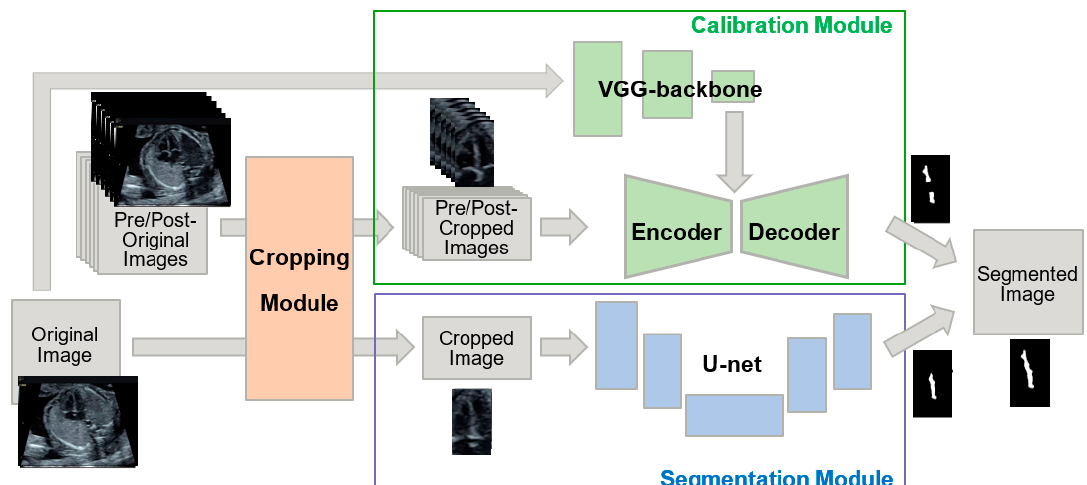
Figure 2. Overview of Cropping-Segmentation-Calibration (CSC). A “cropping module” and “calibration module” were added to improve the U-net-based segmentation results from the “segmentation module”. The cropping module crops out the area around the ventricular septum. Moreover, the calibration module, which consists of an encoder–decoder (ED) and a Visual Geometry Group-backbone module (VGG), calibrated the output of the segmentation module. The ED utilizes time-series information, and VGG utilizes original image information.